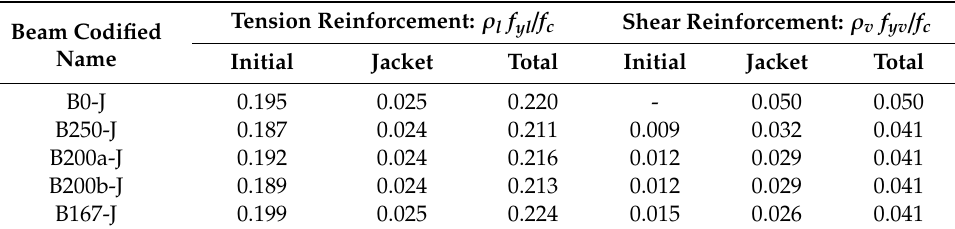
Table 2. Reinforcement ratios of the jacketed beams.